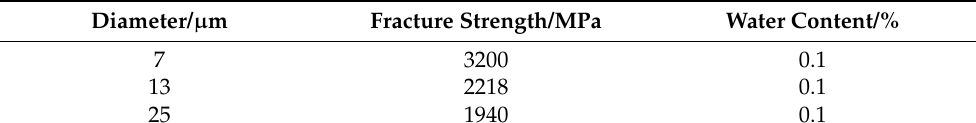
Table 2. The property of basalt fiber.